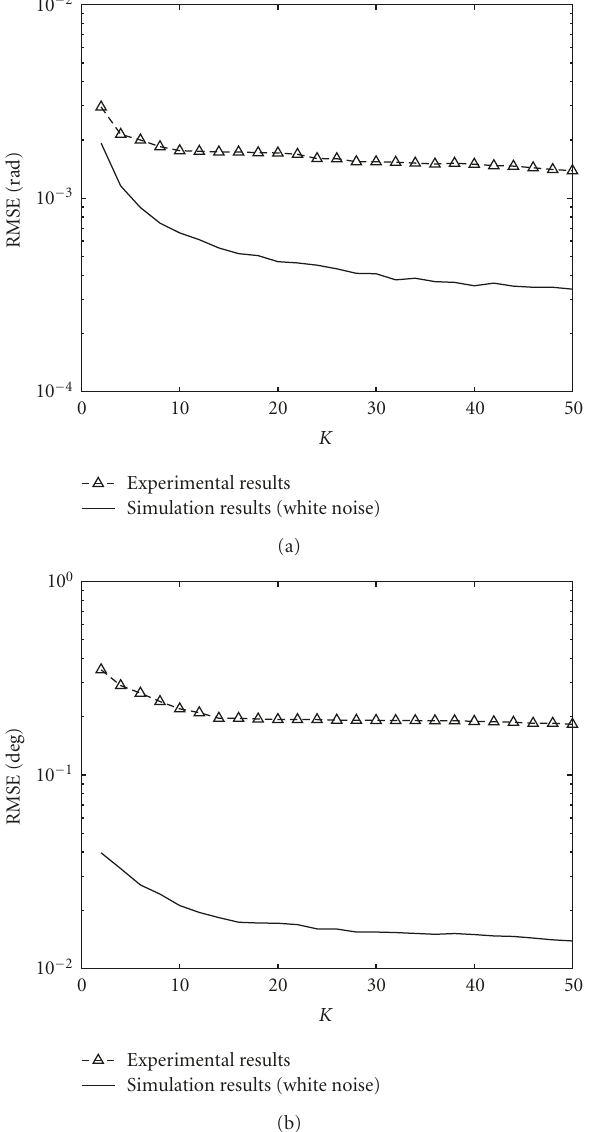
Figure 14: RMSE curves for frequency and DOA estimation of the desired signal as functions of temporal smoothing factor K . ( M = 8, N = 256). (a) Frequency estimation. (b) DOA